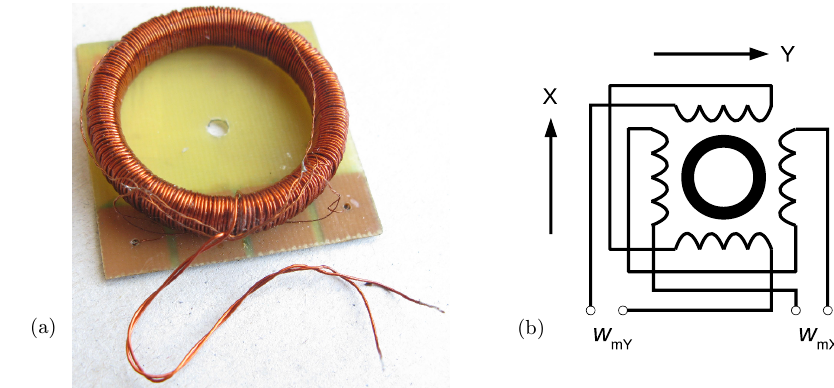
Figure 1. Fluxgate sensor FGS32/11: (a) general view and (b) measuring winding connection diagram.